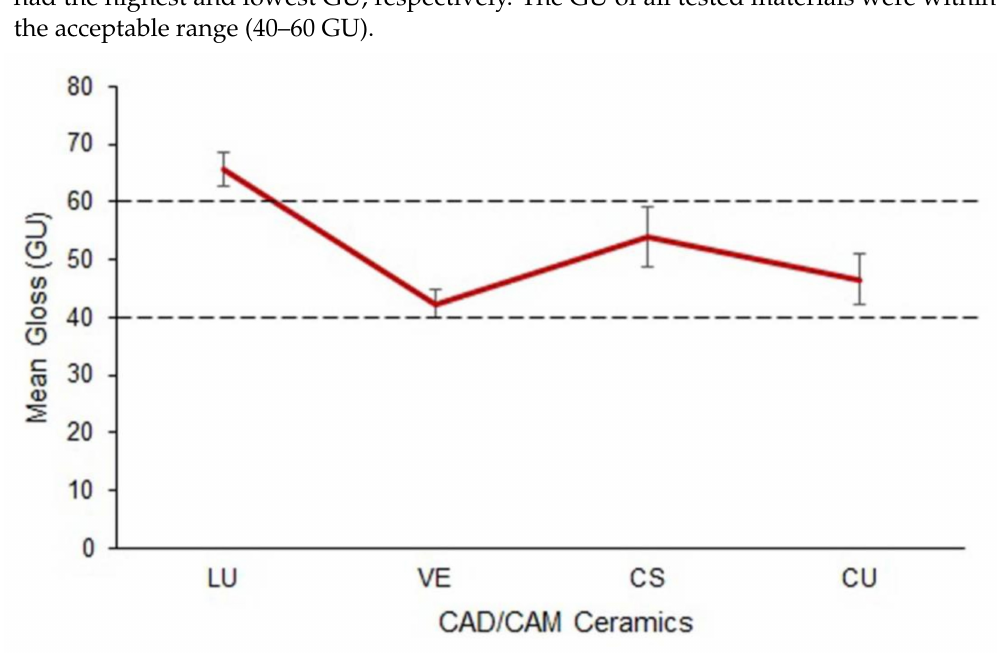
Figure 5. Overall mean GU of the resin-modified ceramics irrespective of the surface treatment. Area between the two dashed line indicates the acceptable GU for ceramic materials (40–60 GU).